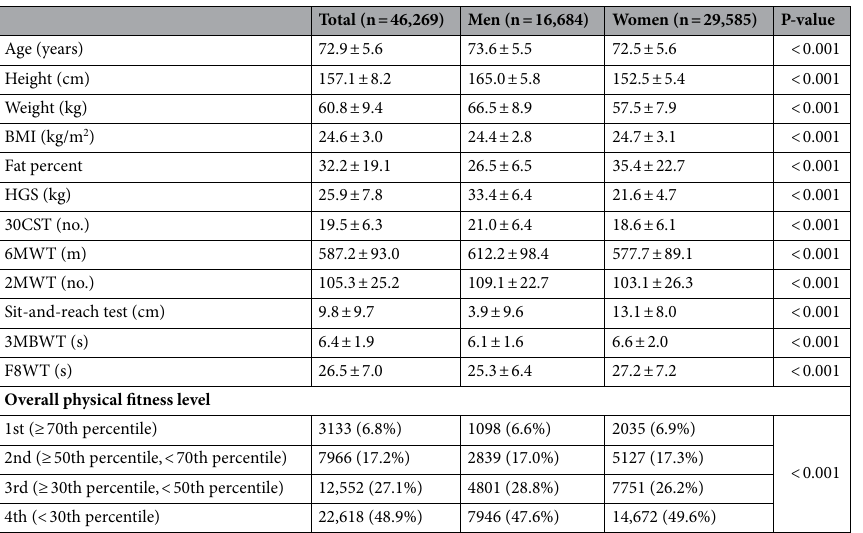
Table 1. Characteristics of the participants. Values are presented as mean ± standard deviation or numbers (%). Data were obtained from 2563 participants for 6MWT and 43,716 for 2MWT. P-values from Student’s